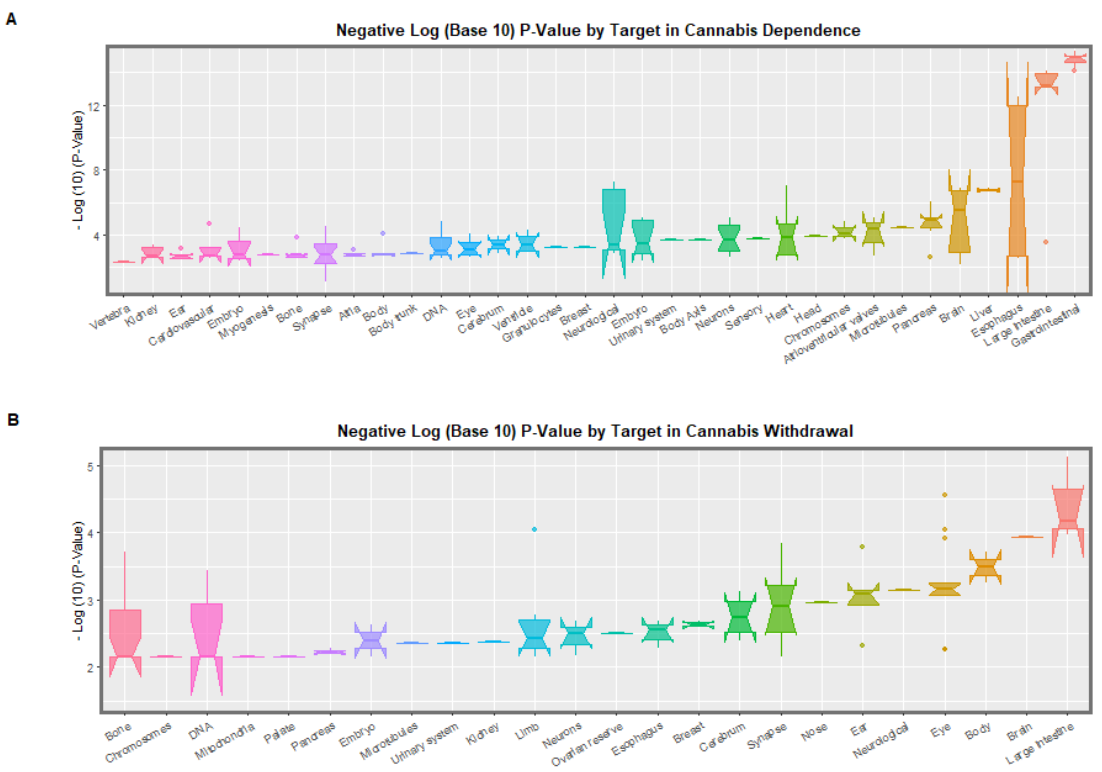
Figure 2. Significance levels (as p -values) of target organs by dependency status in ( A ) cannabis dependence and ( B ) withdrawal in the Schrott database. Table 9. Contrast of Epigenomic Hits for All Congenital Anomalies.by Organ Target, Cannabis De- pendence vs. Withdrawal, Schrott EWAS Database.